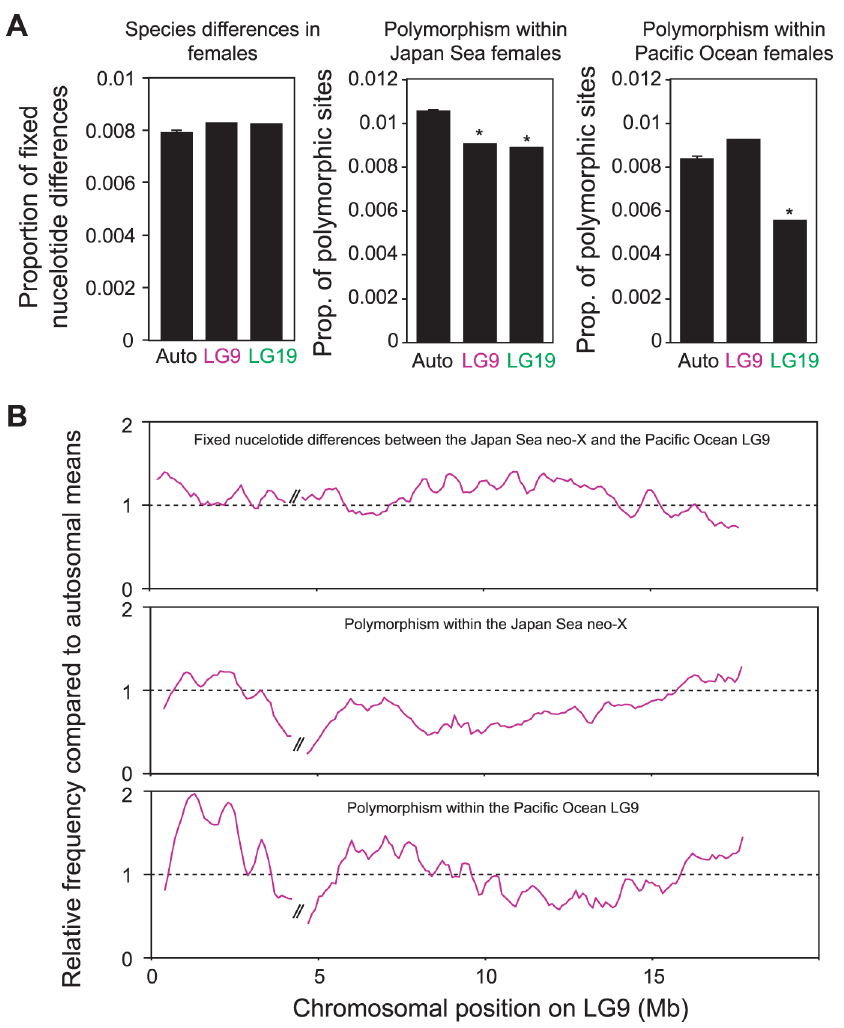
Figure 5. Genomic divergence between the Japan Sea and the Pacific Ocean species. (A) Proportion of fixed nucleotide differences between Japan Sea and Pacific Ocean females (left), polymorphic sites within the Japan Sea females (middle) and polymorphic sites within the Pacific Ocean females (right). A Grubbs’ outlier test was conducted to test whether LG9 and LG19 are outliers of all other linkage groups: *, P , 0.05. (B) Sliding window analysis of proportion of fixed nucleotide differences between Japan Sea and Pacific Ocean females (upper), polymorphic sites within the Japan Sea females (middle) and polymorphic sites within the Pacific Ocean females (lower) for LG9. The window size and the step size were 500 kb and 100 kb, respectively. The two largest supercontigs were analyzed here, and the right one was inverted to provide the correct orientation as in Figure 2. The gap between these two supercontigs is indicated by//in the figure. Proportions are shown as relative values compared to autosomal means. and incomplete dosage compensation, because no correlation was found between sex differences in mRNA expression levels and CGH signals (Figure 6B; Pearson’s correlation, r = 0.019, P = 0.47). Instead, we found a significant correlation between sex differences in mRNA expression levels and the number of heterozygous SNPs upstream of the genes in Japan Sea males (i.e., nucleotide differences between the neo-X and the neo-Y chromosomes) (Figure 6C; for the 10-kb upstream, Pearson’s correlation, r = 0.072, P =0.020; for the 3-kb upstream, r = 0.055, P = 0.072). No significant correlation was found between sex difference in mRNA expression levels and the number of heterozygous SNPs upstream of the genes on LG9 of Pacific Ocean males (for the 10-kb upstream, Pearson’s correlation, r = 0.016, P = 0.60; for the 3-kb upstream, r = 2 0.015, P = 0.63). These data suggest that either substitutions between the neo-X